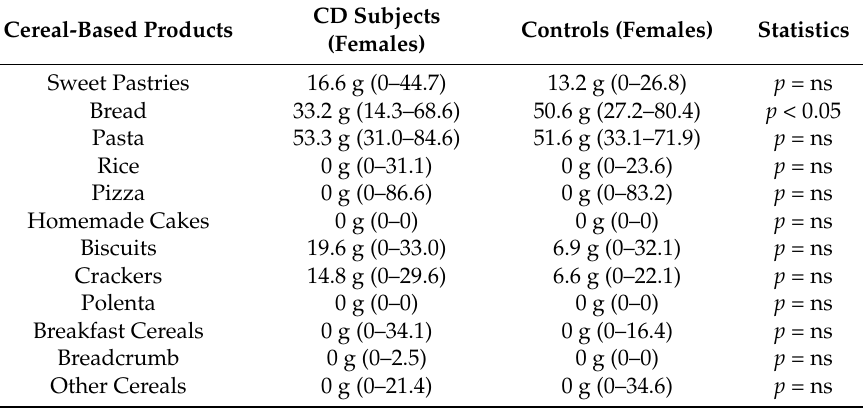
Table 4. Median and inter-quartile range daily consumption of cereal-based products among CD patients and controls (females). Comparison was made by Mann–Whitney